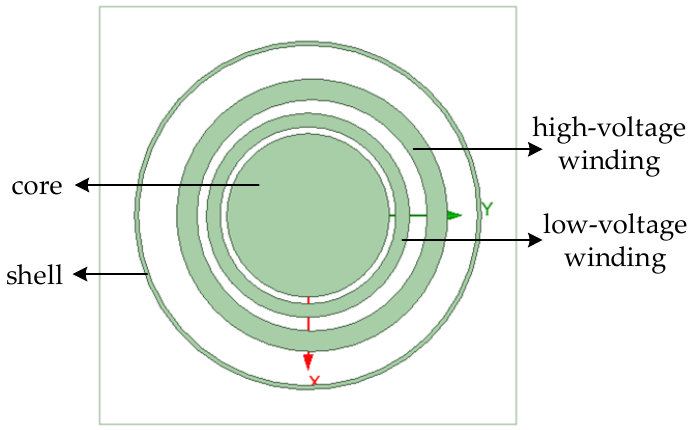
Figure 9. Top view of high-voltage winding inclined at 30 mm.